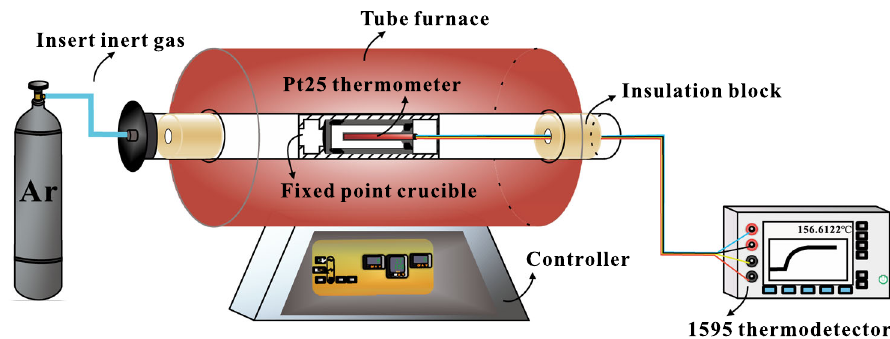
Fig. 4 Experimental test system and tube furnace diagram